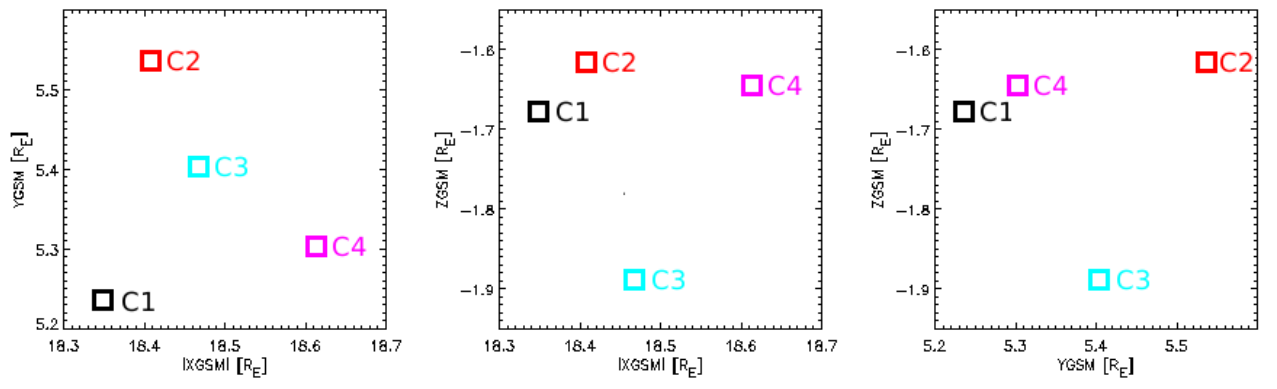
for longer time scales. Unlike in Fig. 6, the components of ∇ ⊥ p are now negative (c, d), and W . 2 pW/m 3